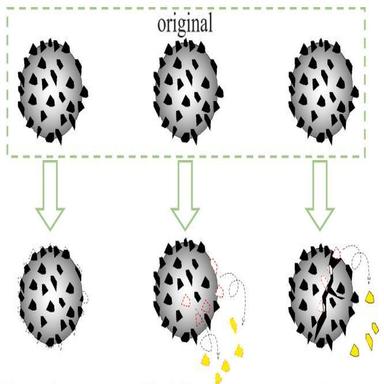
The wear mechanism of MAPs.